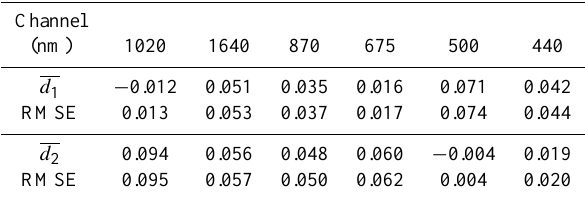
Table 7. Averaged τ a differences ( d 1 ) for seven nights period (9– obtained with calibration Method#1 and #3 using CE-1 photome- ter data. d 2 corresponds to τ a differences in the same time period between Method#1 and #3 assuming a solid angle reported by the manufacturer, (cid:127) ref =3.4 × 10 − 4 sr.